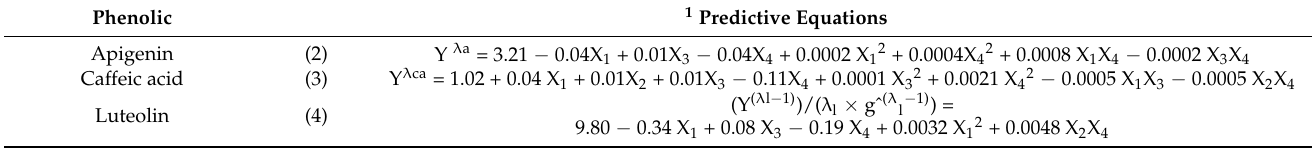
Table 4. Quadratic models of polynomial predictive equations of response surface for apigenin, caffeic acid, and luteolin UAE from parsley.